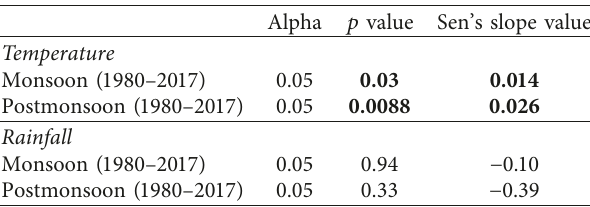
Figure 4: Seasonal mean temperature and rainfall records of northern monsoon region of Pakistan during the time period of 1980–2017 (a) for monsoon months of June, July, August, and September and (b) for postmonsoon months of October and November. Table 1: Man-Kendall test and Sen’s slope values for temperature and rainfall